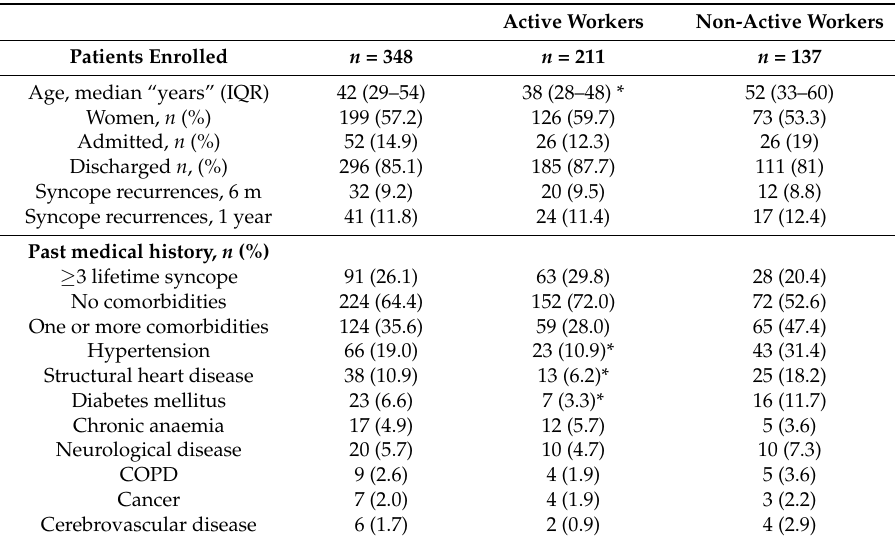
Table 1. Demographic and Clinical Features of the Studied